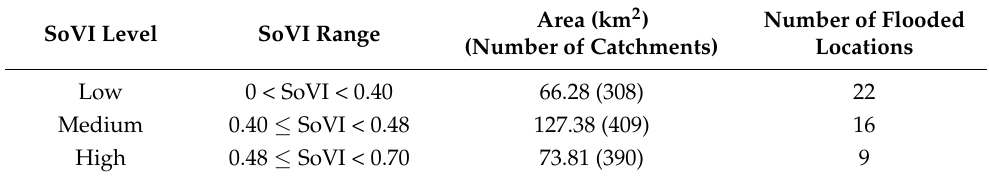
Figure 7. Results of SoVI at catchment level ( a ) and the relationship between aggregated SoVI score from NRI dataset and our calculations of SoVI ( b ). Table 3. Summary of SoVI values of flooded locations based on SoVI level.